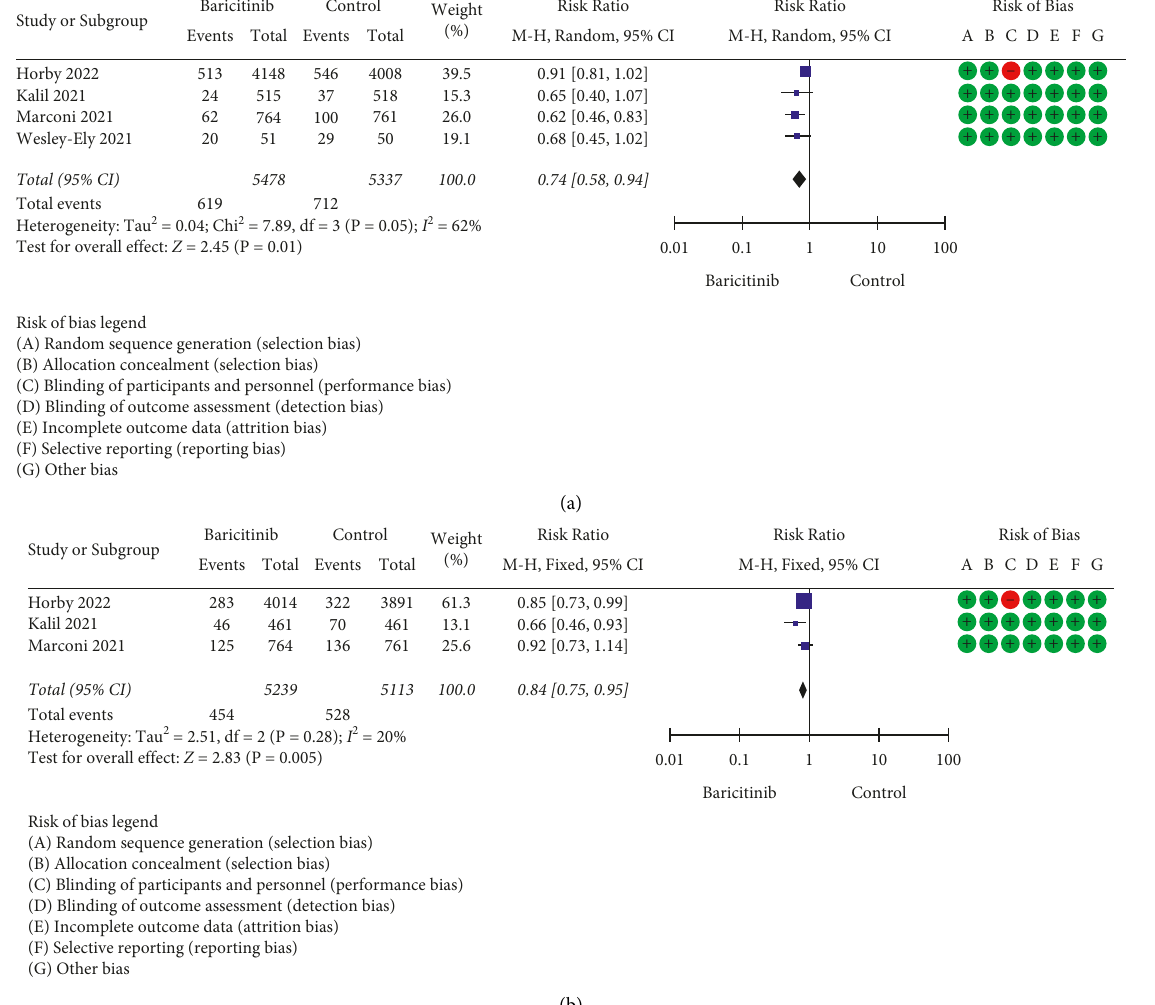
(D) Blinding of outcome assessment (detection bias) (E) Incomplete outcome data (attrition bias)